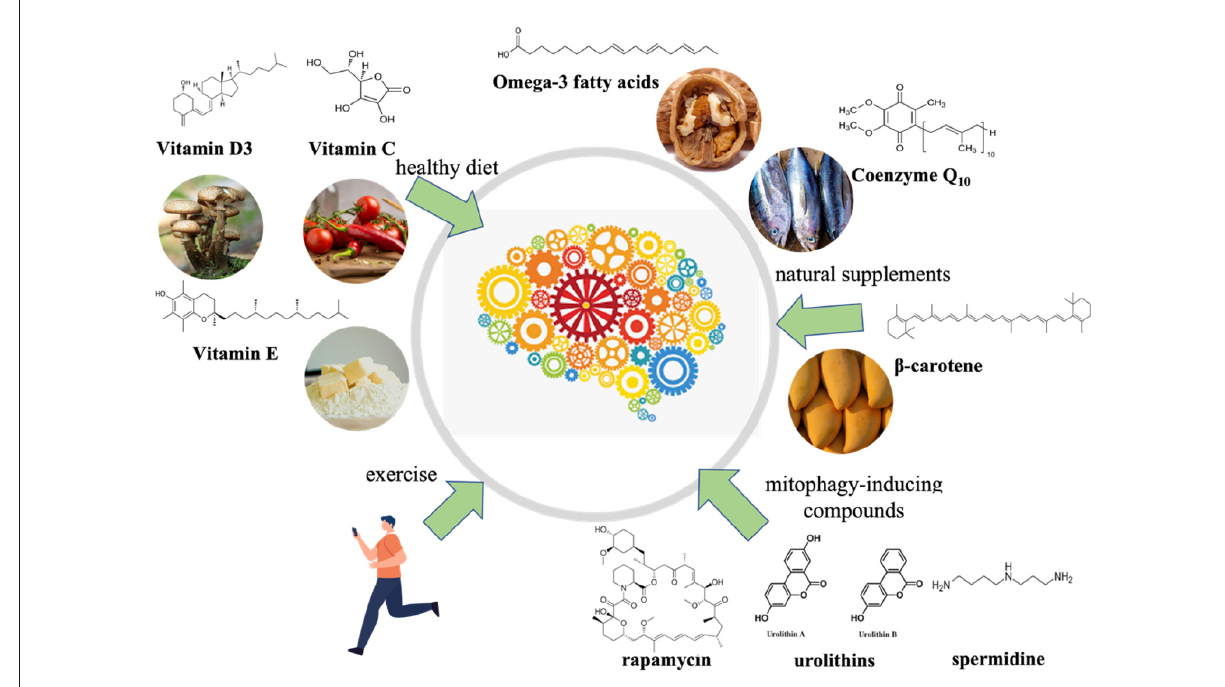
FIGURE3 Multiple antioxidant strategies to prevent and cure Parkinson’s